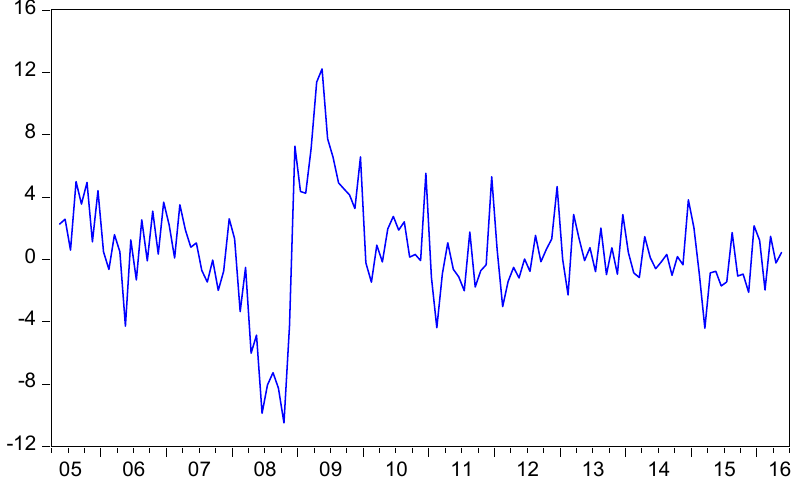
Figure 2. Time series for OLS estimates of TFCI (April 2005–June 2016).